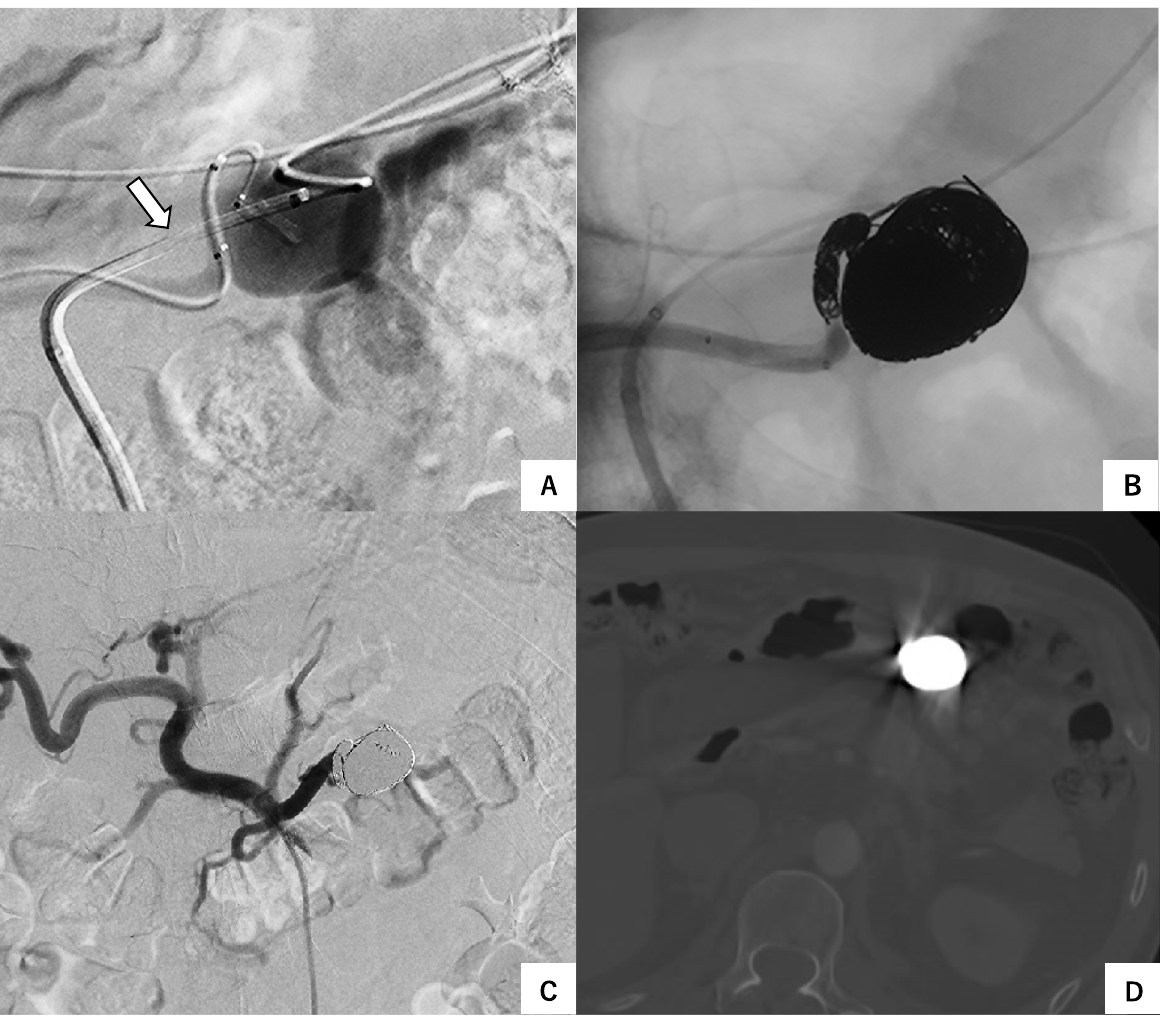
Fig. 3 A The 4-axis catheter system (white arrow) was used due to the long and tortuous distance from the celiac artery. B The sac and the end of the feeding artery were embolized with microcoils. C Celiac arteriography after embolization. D Contrast-enhanced CT 6 months after embolization showed complete